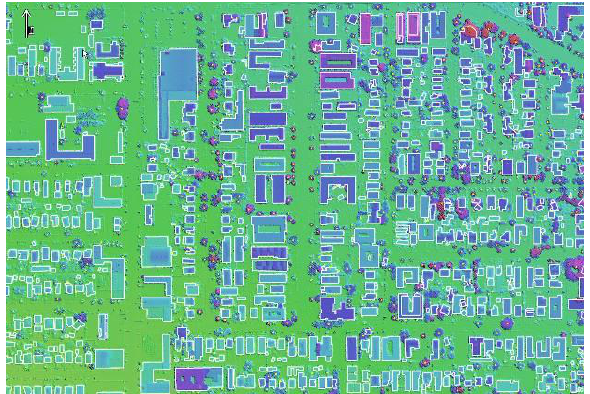
Figure 12. Rectangular buildings and houses easily extracted.